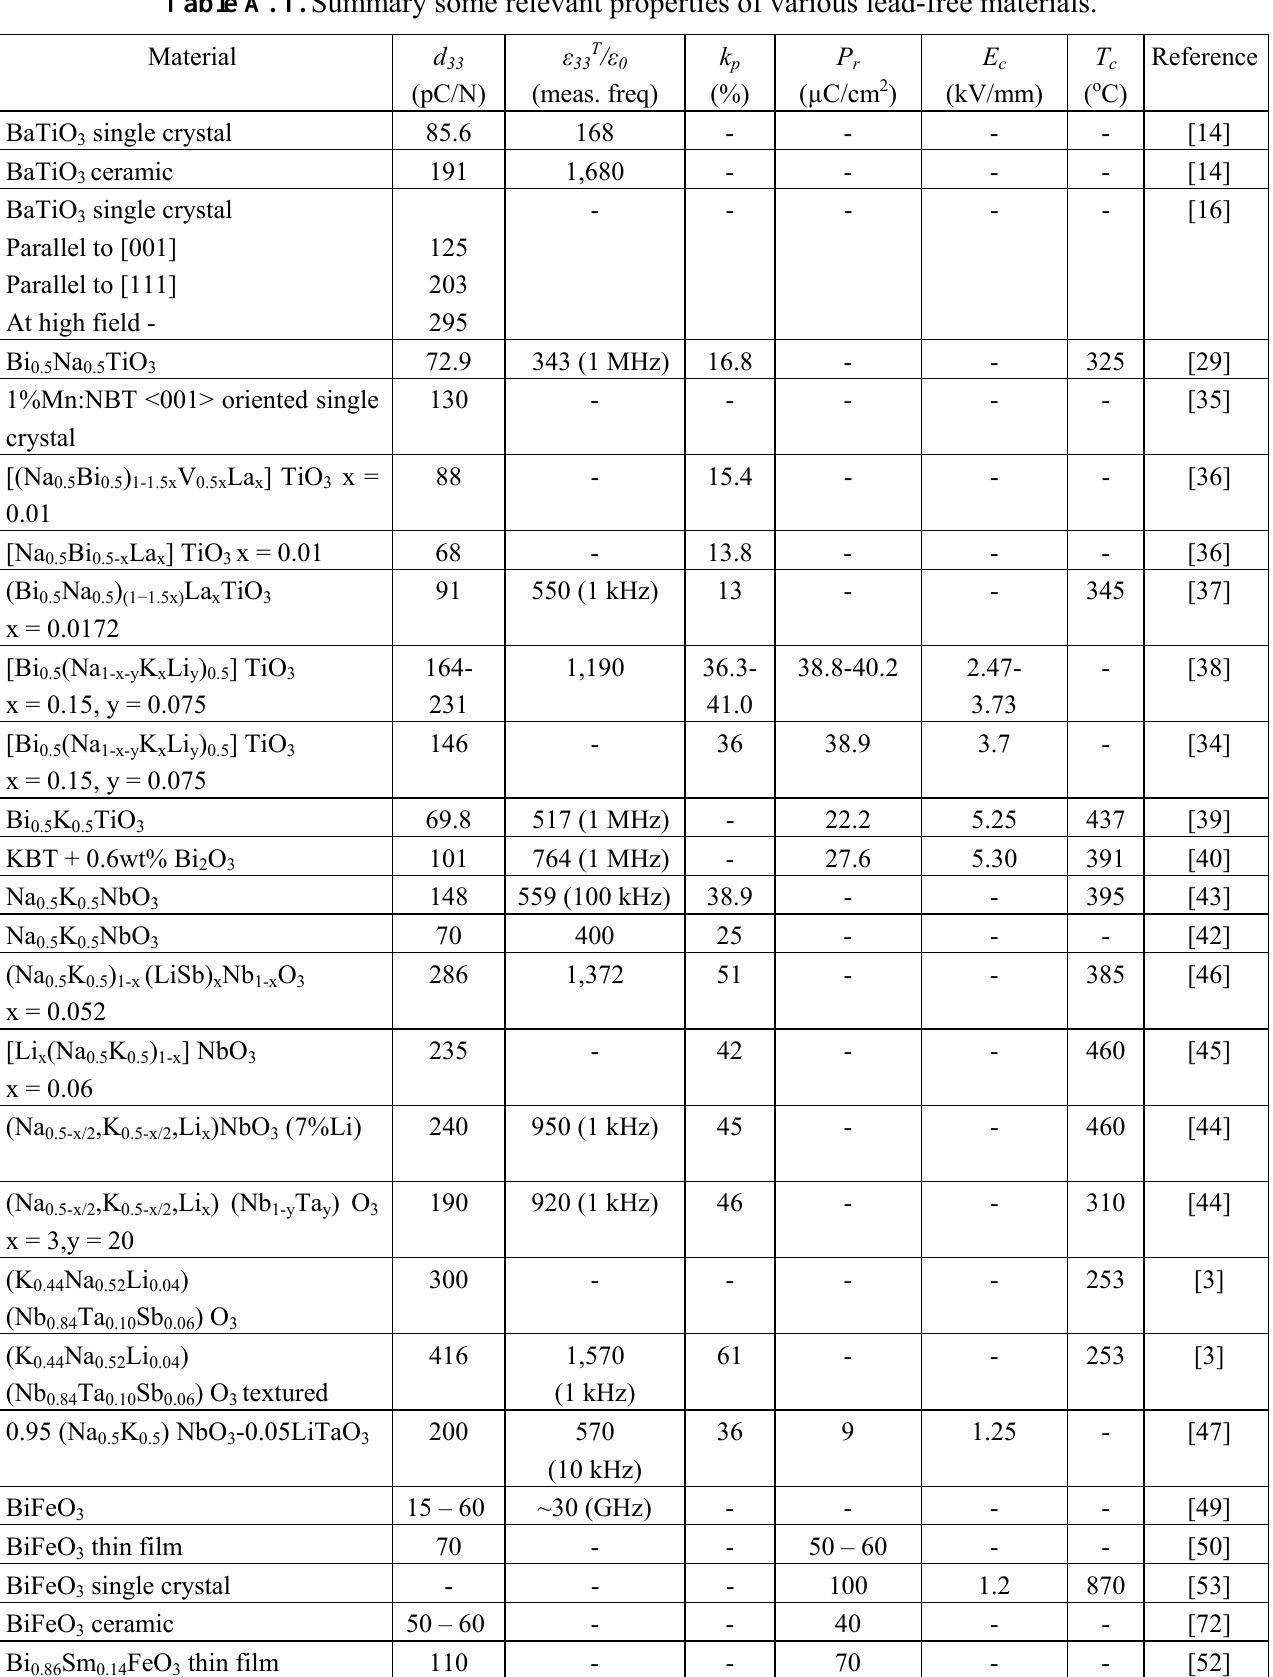
Table A. 1. Summary some relevant properties of various lead-free